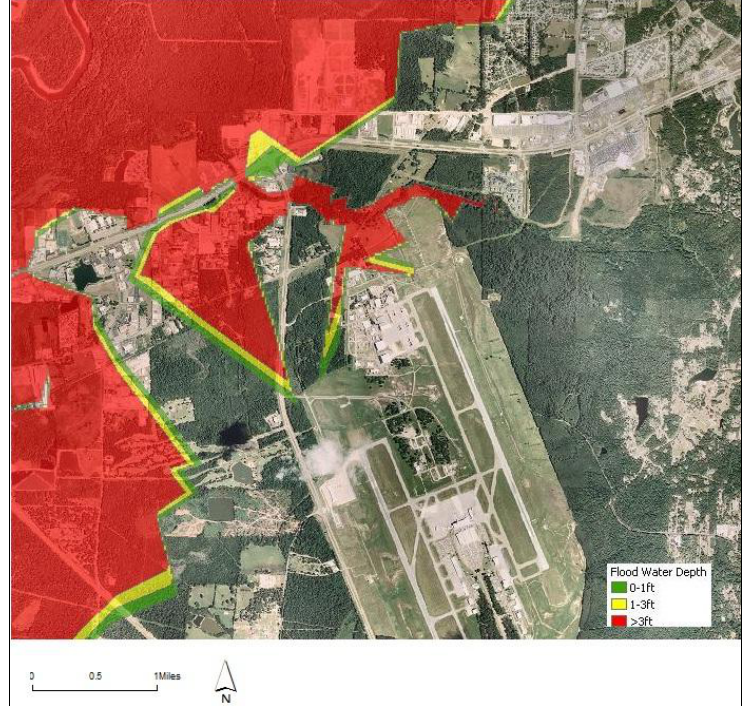
Figure 22. Spatial representation of flood waters near Jackson International